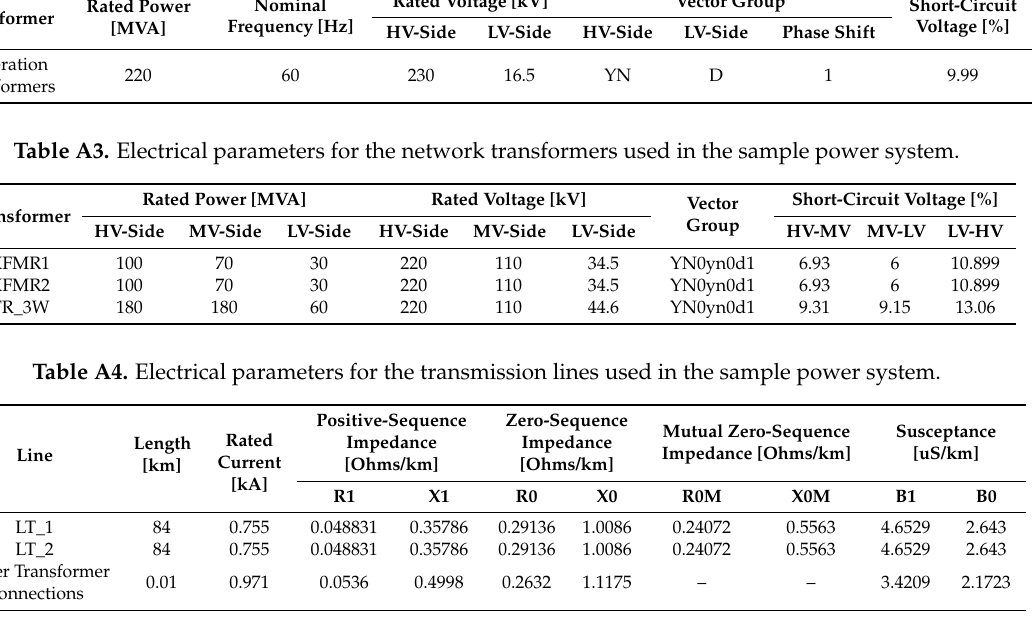
Table A2. Electrical parameters for the generation transformers used in the sample power system. Transformer